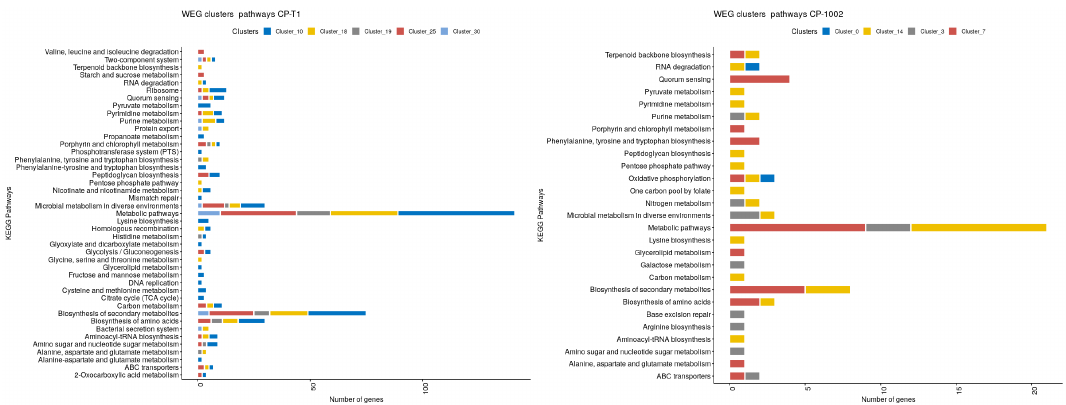
Figure 5. Pathways of the clusters where the influential genes were present in the whole expressed genome network. Left: CP-1002; right: